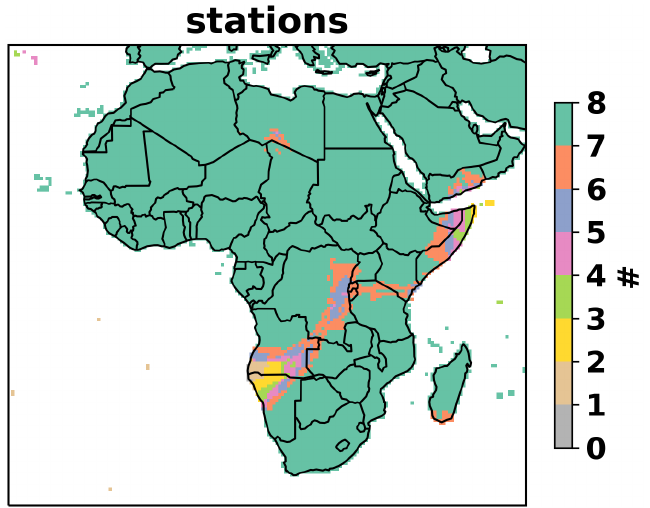
Figure 2. Average number of stations used per timestep in the interpolation of CRU (Climatic Research Unit) TS4.02 near-surface temperature from 1981 to 2017. Eight is the maximum number of stations